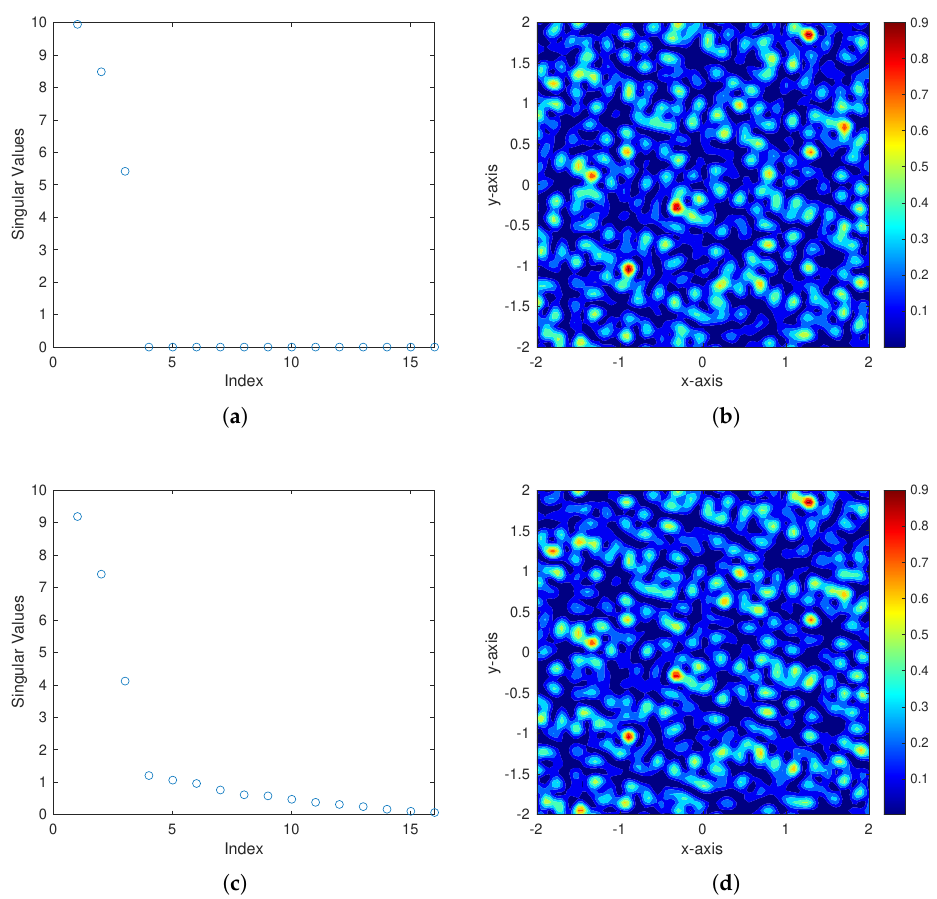
Figure 12. Singular value distribution and imaging results for the case with the largest mean square error case among the test data. ( a ) SVD with true data; ( b ) imaging result with true data; ( c ) SVD with learning data; ( d ) imaging result with learning